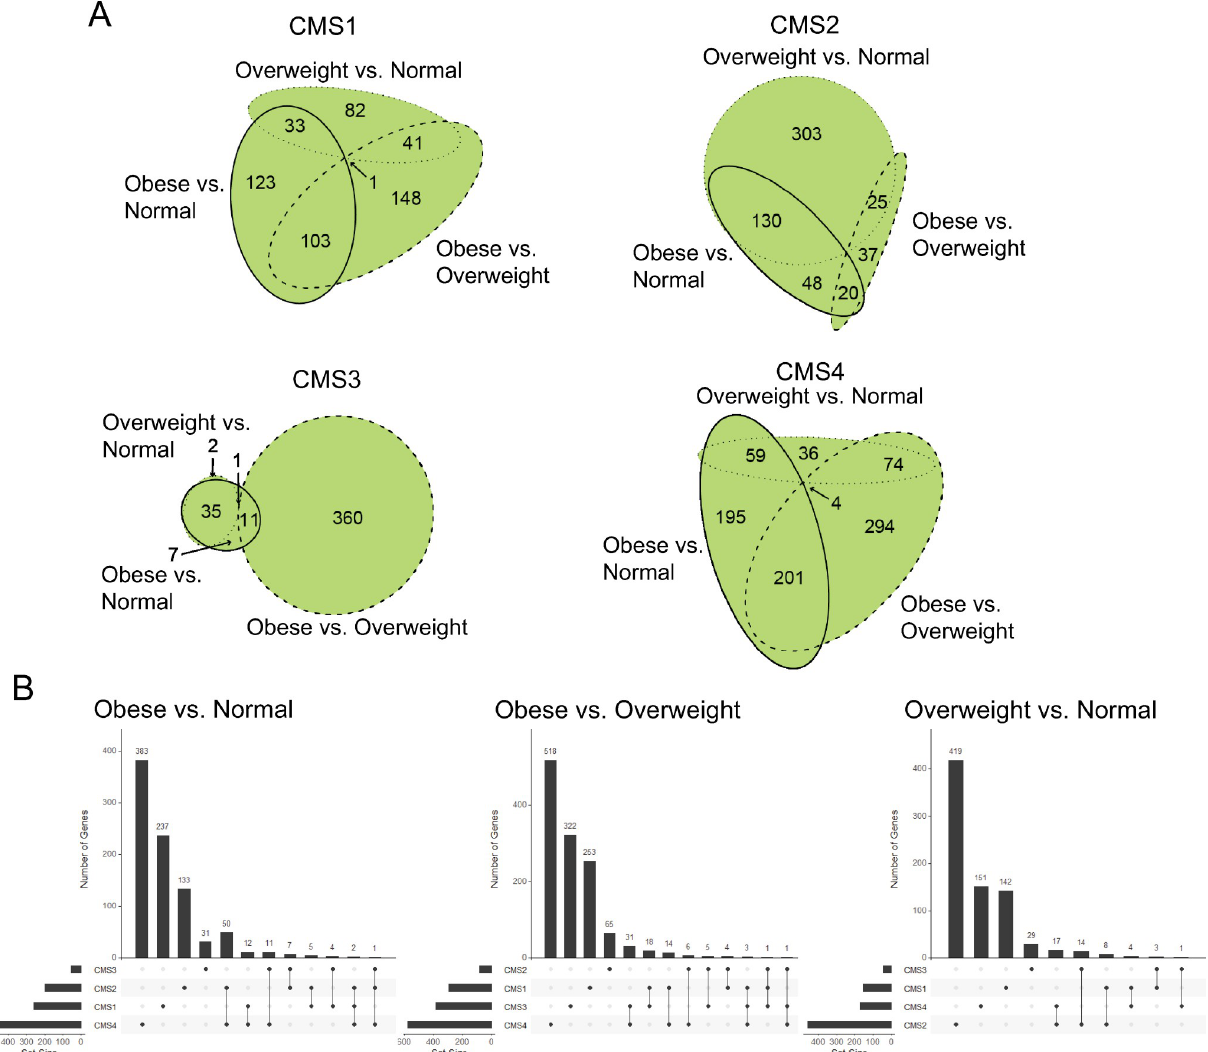
Fig 2. Differential expressed gene analysis reveals CMS-specific differences between BMI groups. (A) Euler diagrams were used to visualize the weighted overlap of DESeq2-obtained DEGs (MeanBase > 10, FDR p value < 0.05) between Obese vs. Normal, Obese vs. Overweight, and Overweight vs Normal DEGs for each CMS category. The R package eulerr was used to construct the Euler diagrams. (B) Upset plots were used to visualize the intersection of DEGs between the four CMS categories for each BMI comparison. The R package UpsetR was used to construct the Upset